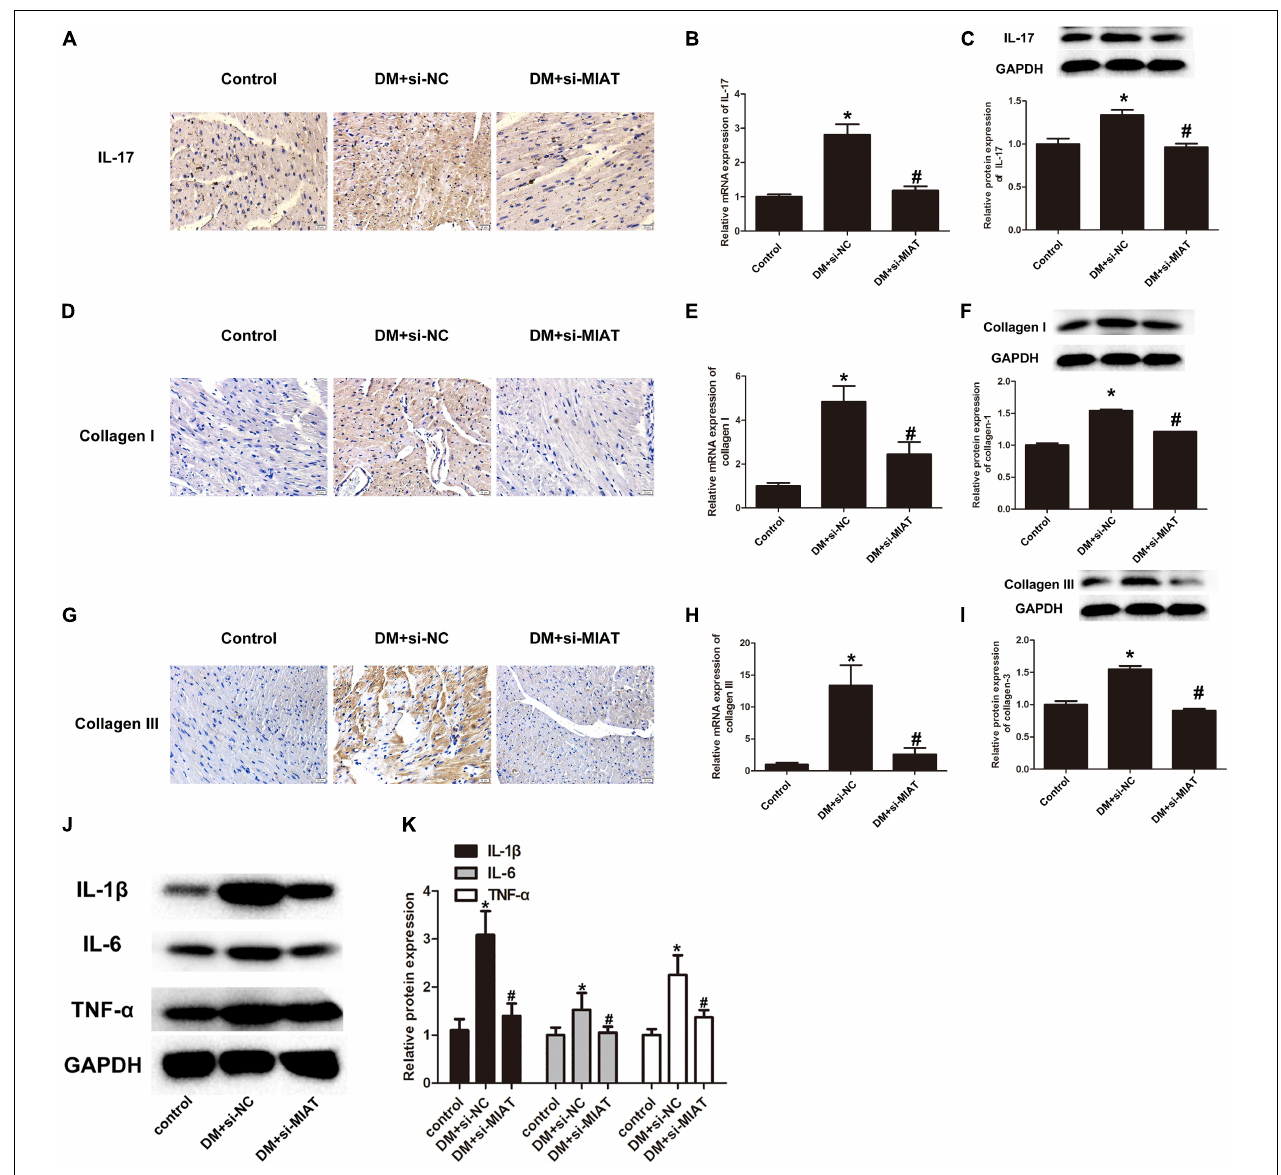
FIGURE 6 | LncRNA-MIAT promote cardiac inflammation in DM mice. (A,D,G) IHC staining of IL-17, collagen I, and collagen III in the hearts harvested from control, DM and DM-siMIAT mice at the end of the experiment. The pictures were captured using 100 × objective. (B,E,H) The expression levels of IL-17, collagen I, and collagen III in the hearts harvested from control, DM and DM-siMIAT mice were detected by q-RT-PCR; * p < 0.05, # p < 0.01. (C,F,I–K) Tissue homogenate of mice heart with above-mentioned treatments were collected and processed for western blotting to examine the protein expression of IL-17, IL-1 β , TNF- α , IL-6, collagen I, and collagen III, respectively, as Figure 2B mentioned. Densitometric analysis was also performed as described in Figure 2B ; * p < 0.05, # p < 0.01. Since we probed the target protein from the same membrane. The loading control was reused in this